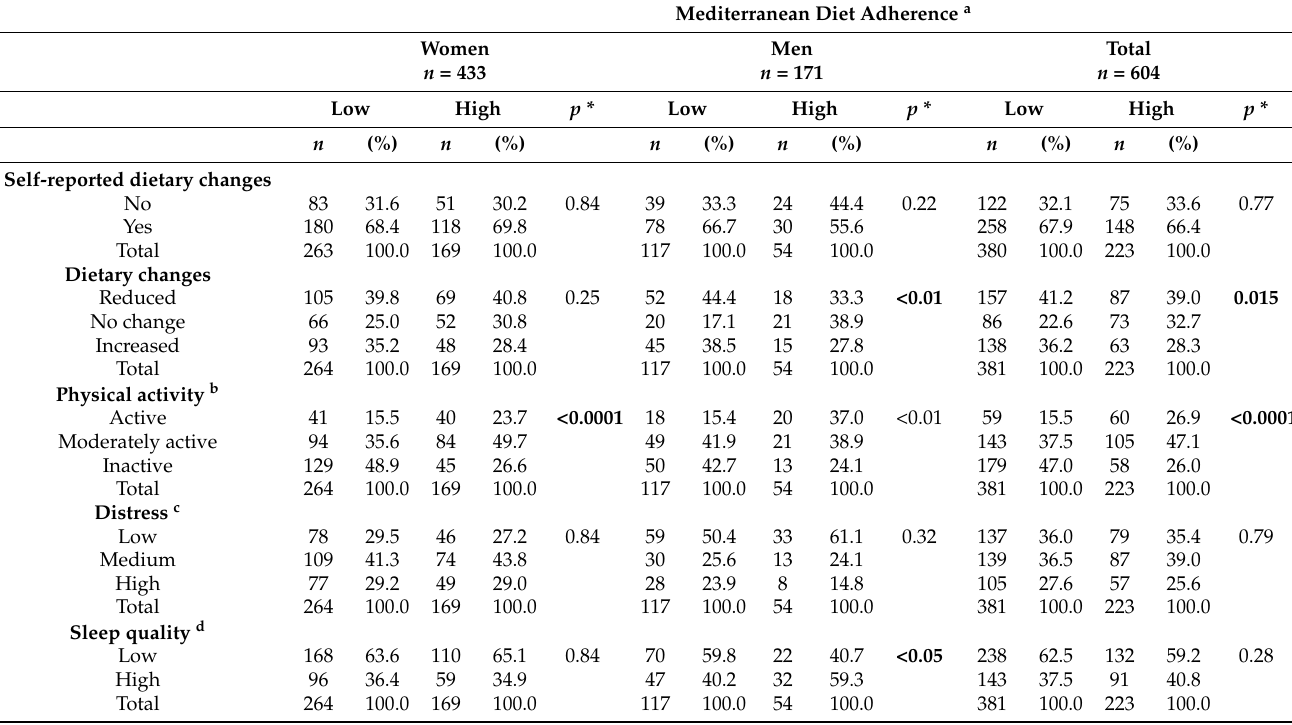
Table 3. Distribution of responses for levels of adherence to the Mediterranean diet, physical activity, distress, and sleep quality in the total subjects and by sex.